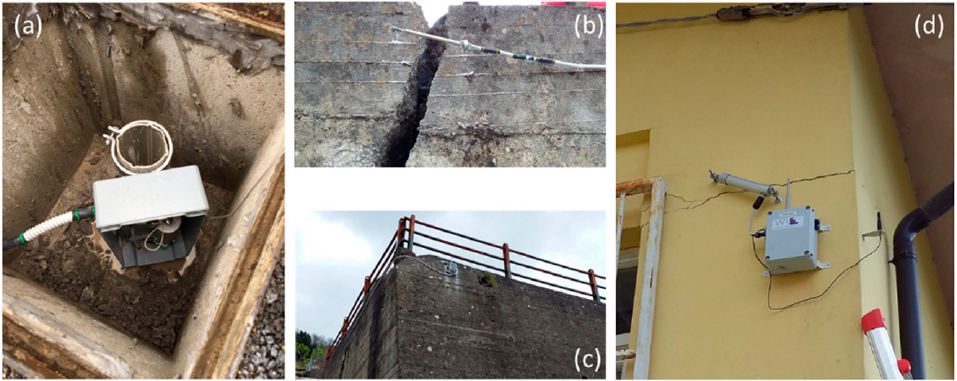
Figure 2. Some examples of sensors included in the WSN monitoring system: ( a ) a wire extensometer coupled with an inclinometer; ( b , c ) a bar extensometer with the related node (E3); ( d ) another bar extensometer with its node mounted on the façade of the school (E4).